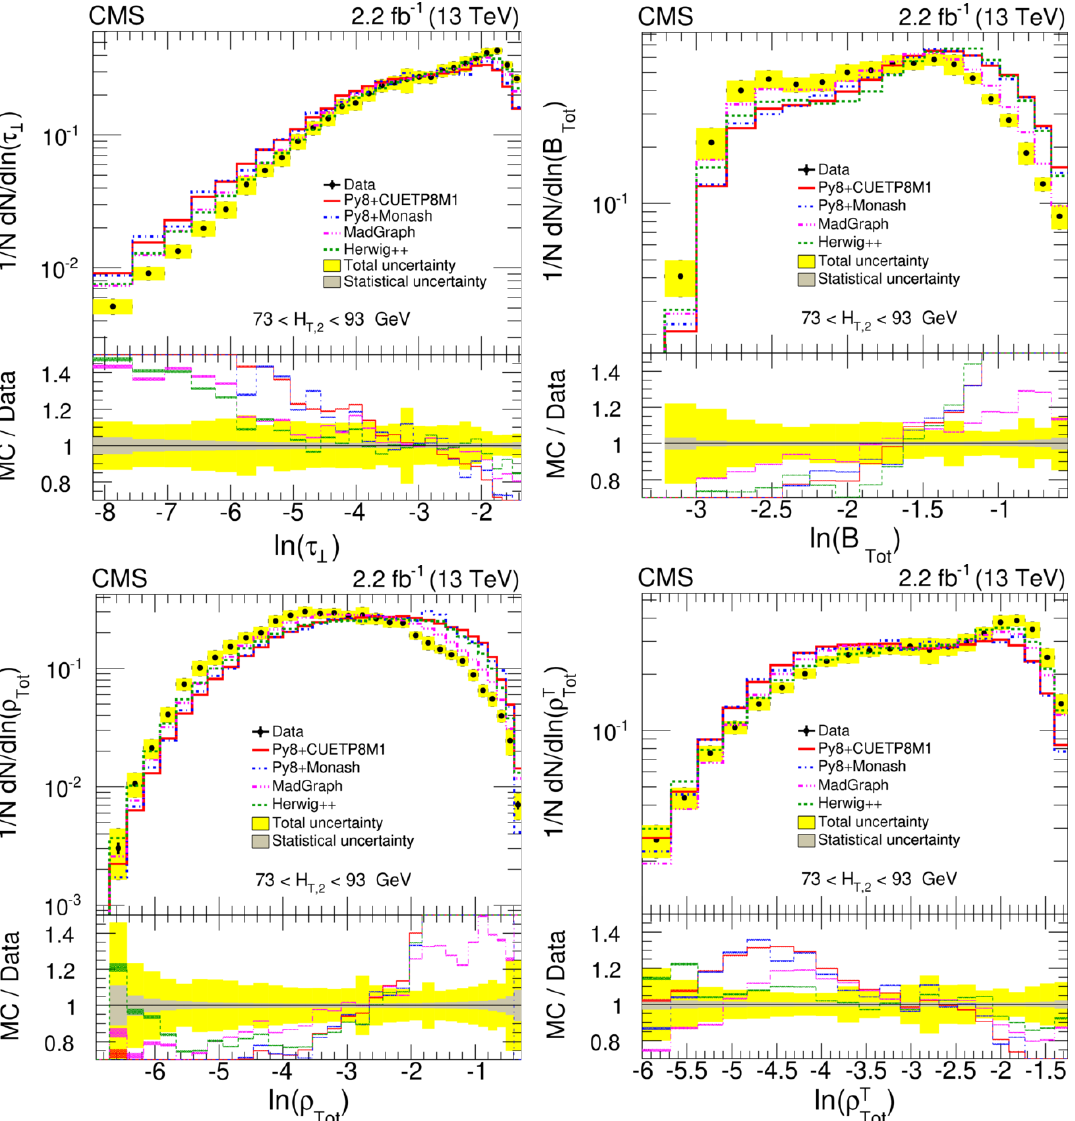
Figure 3 . Normalized di(cid:11)erential distributions of unfolded data compared with theoretical (MC) predictions of pythia 8 CUETP8M1 (red line), pythia 8 Monash (blue dash-dotted line), Mad- Graph 5 a mc@nlo (pink dash-dot-dotted line) and herwig++ (brown dash-dot-dotted line) as a function of ESV: complement of transverse thrust ( (cid:28) ? ) (upper left), total jet broadening ( B Tot ) (upper right), total jet mass ( (cid:26) Tot ) (lower left) and total transverse jet mass ( (cid:26) T 73 < H T ; 2 < 93 GeV. In each ratio plot, the inner gray band represents statistical uncertainty and the yellow band represents the total uncertainty (systematic and statistical components added in quadrature) on data and the MC predictions include only statistical